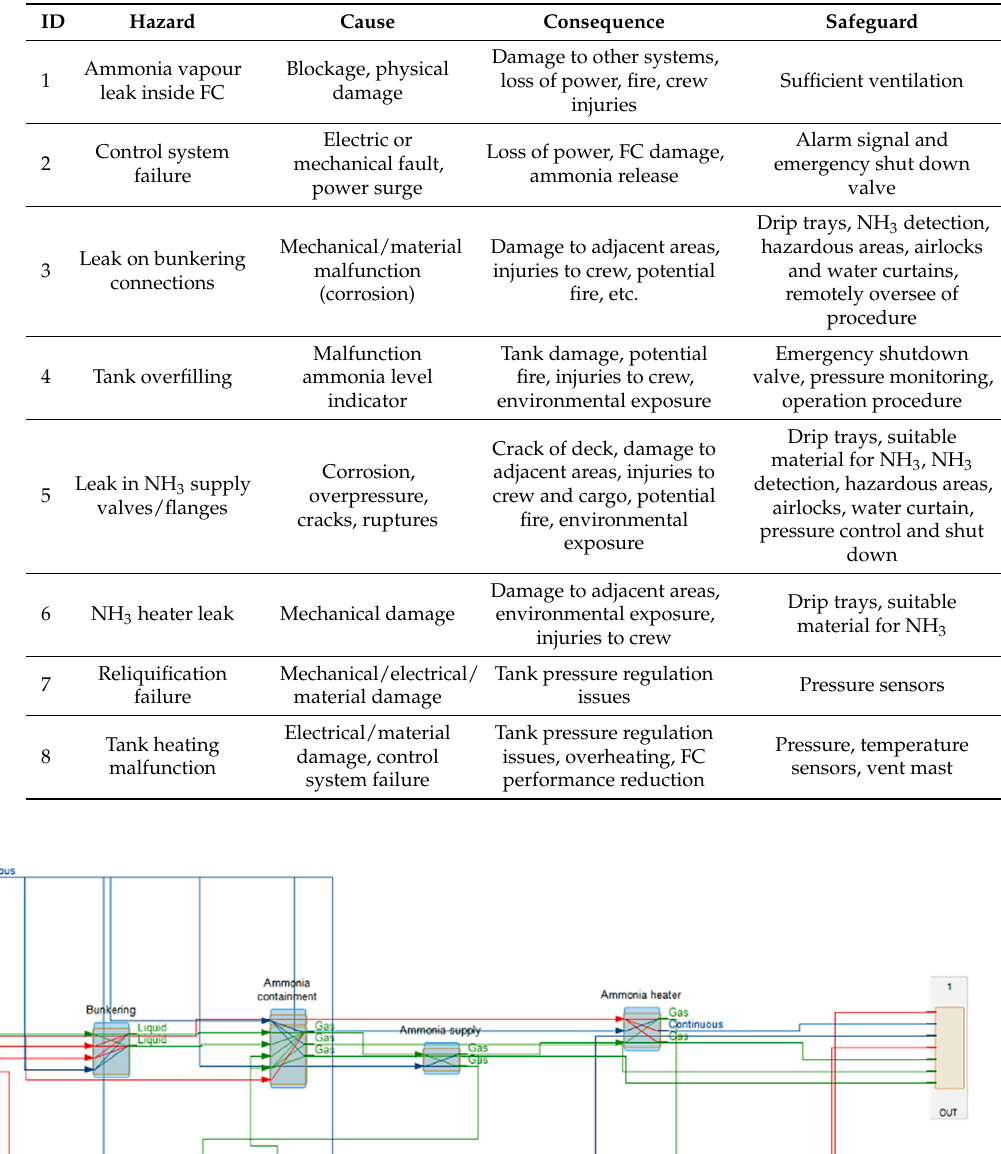
Table 2. Hazards and safeguards.